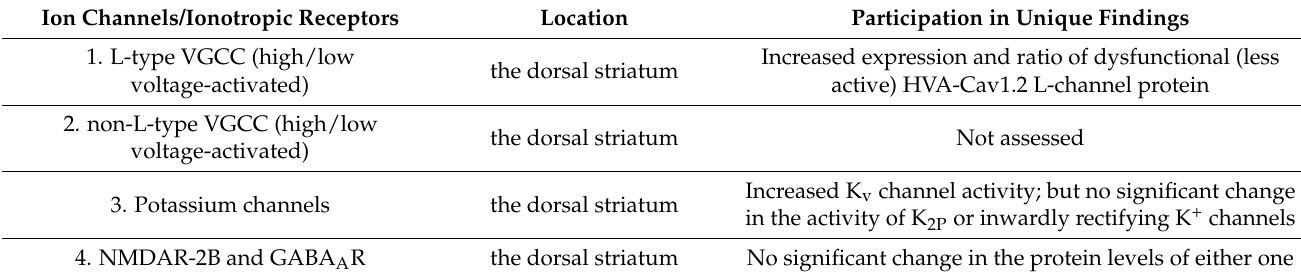
Table 2. Summary of the changes in membrane ion channels and ionotropic receptors assessed in GABAergic medium spiny neurons from 12mo HIV-1 rats in comparison with age-matched non-Tg